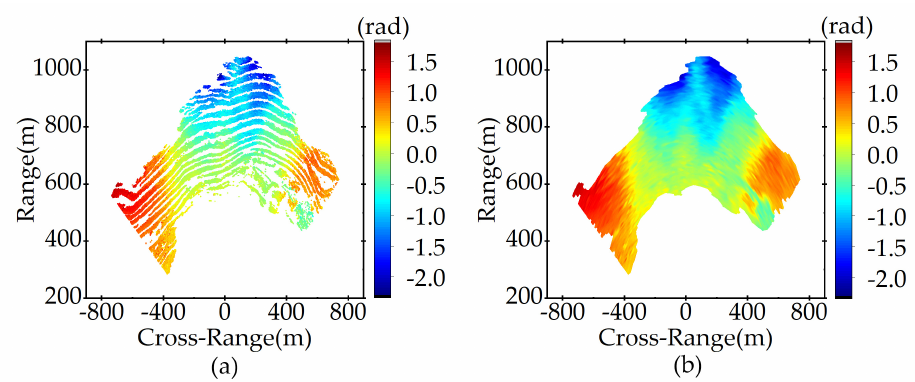
Figure 7. Distribution of the original PSs and the corresponding complete PSs (CPSs) after pre- processing: ( a ) original PSs, ( b ) CPSs.